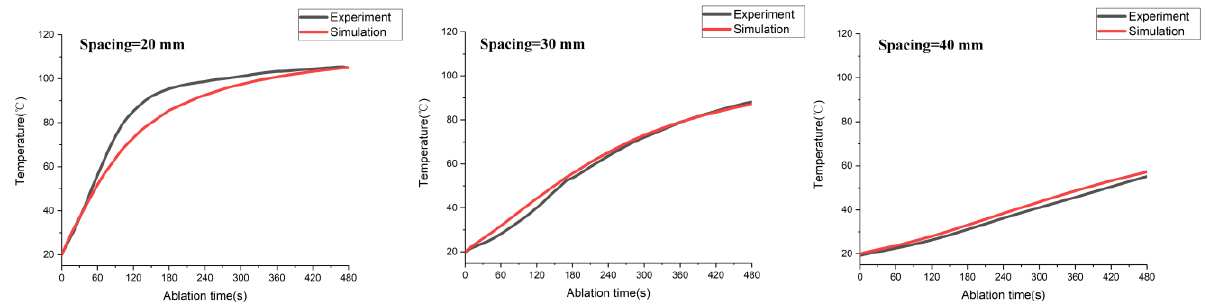
Figure 4. Comparisons of the average temperature changes at P1 and the simulation results (three different dual-antenna spacings: 20 mm, 30 mm, and 40 mm, under the same heating parameters of 50 W matrix input power and 8 min treatment